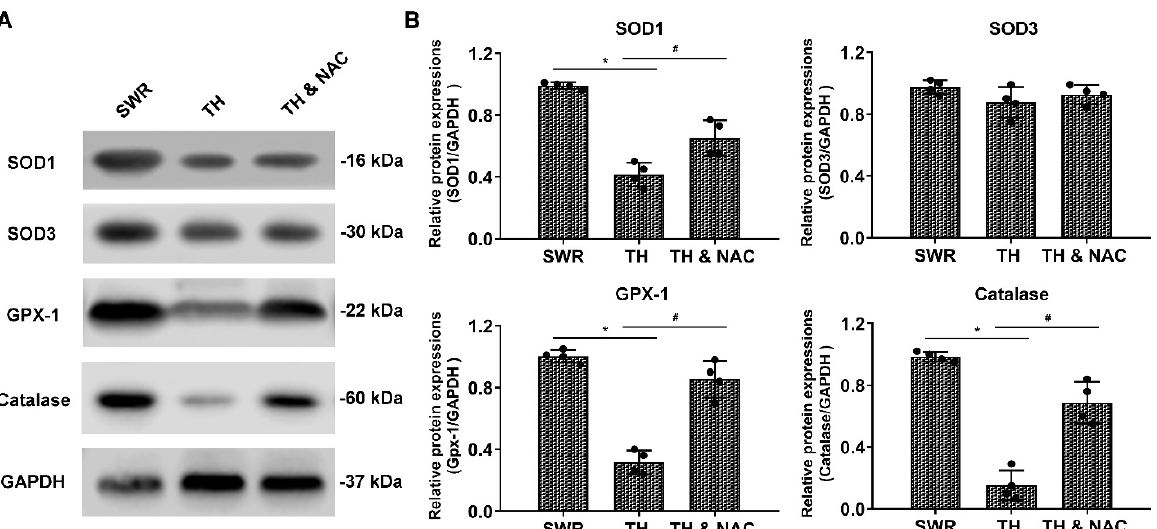
Figure 6. NAC preserved the expression of antioxidant enzymes in ischemic muscle in type-2 diabetic mice. To exam the effect of NAC on the expression of antioxidant enzymes in diabetic ischemic limbs, ischemic muscle tissue was harvested for Western blot analysis. As demonstrated in panels ( A , B ), the expression of SOD-1, Gpx-1, and catalase were significantly decreased in diabetic ischemic limbs compared to non-diabetic control ( n = 4, * p < 0.05 for TH versus SWR); there was a trend towards a decreased expression of SOD-3, but it was not significant statistically. NAC treatment significantly prevented the reduction in the expression of SOD-1, Gpx-1, and catalase in diabetic ischemic limb muscle tissue ( n = 4, # p < 0.05 for TH versus TH & NAC). SOD-1, copper-zine superoxide dismutase in cytoplasm; SOD-3, extracellular SOD; Gpx-1, glutathione peroxidase-1; GAPDH, glyceraldehyde 3-phosphate dehydrogenase; TH, diabetic TALLYHO/JngJ mice with CLI operation; SWR, non-diabetic SWR/J mice with CLI operation; TH & NAC, TALLYHO/JngJ mice with CLI operation plus NAC treatment. All data are shown as means ± SD. Significant differences were determined with one-way ANOVA with Bonferroni’s post hoc test or Kruskal-Wallis test with Dunn post hoc test.